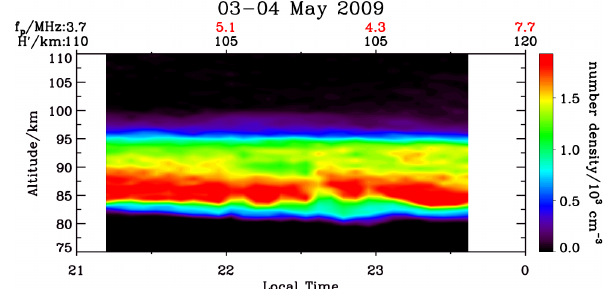
Figure 2. Na density contour plot and E s layer parameters during the night of 3–4 May 2009. For detailed explanation please see text. Notice the E s layer occurred without any Na s layer during the entire observation of Na